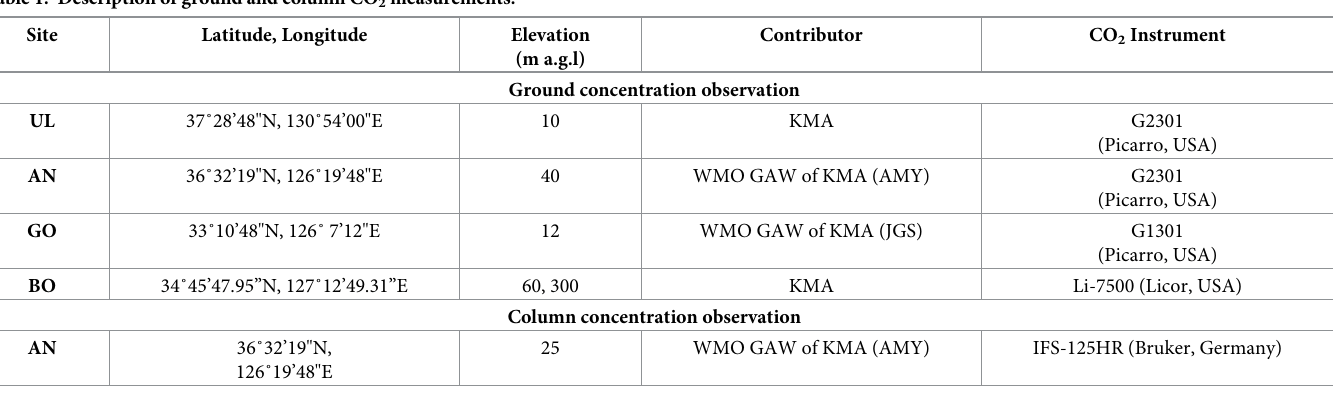
Table 1. Description of ground and column CO 2